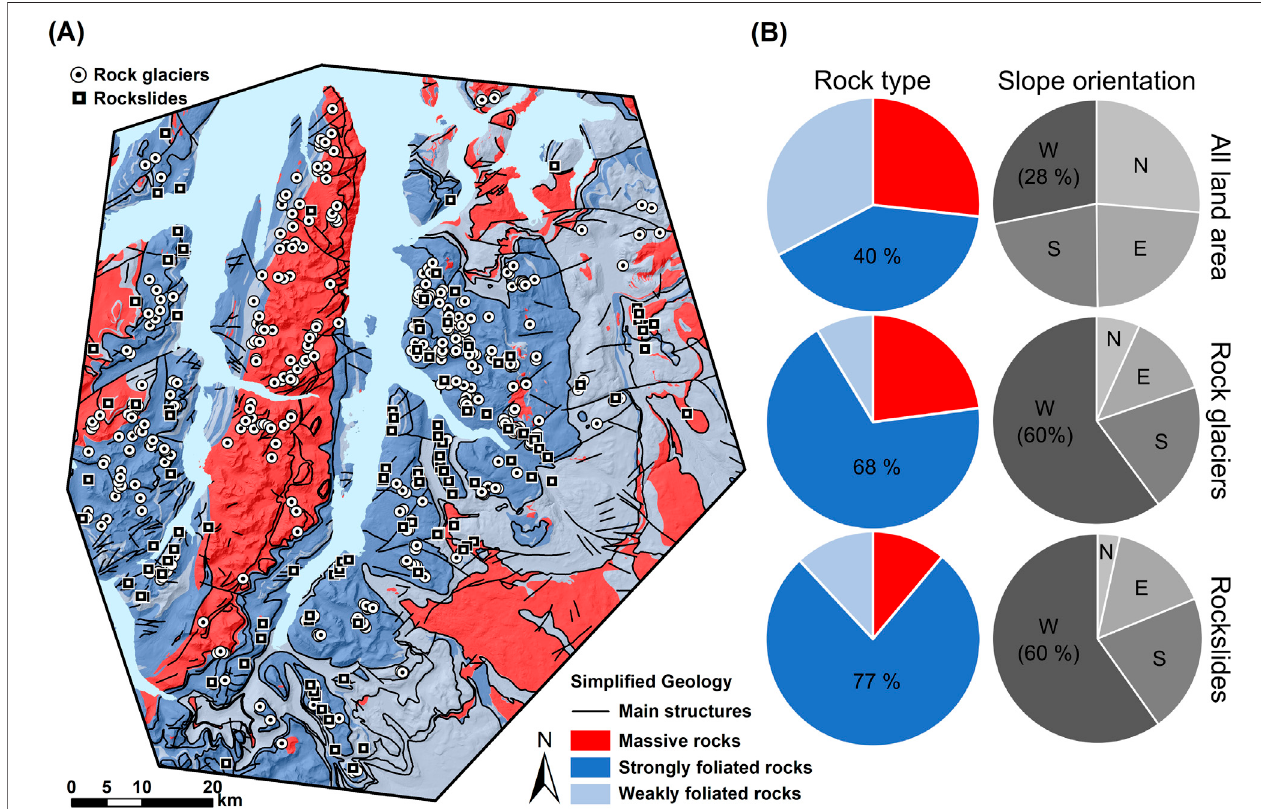
FIGURE 13 | Rock glacier (RG) and rockslide (RS) distribution and geological factors. (A) Simpli fi ed geological map, classi fi ed into 1135 three main rock types (massive, strongly foliated and weakly foliated) and structural information 1136 (major faults, joints and shear zones) from a 1:250 000 geological map of the area (NGU, 2020a; 1137 Zwaan, 1988; Zwaan et al., 1998). (B) Pie charts comparing the fraction of rock type and slope 1138 orientation for all land areas and RG/RS landforms. Slope orientation is based on a 10 m DEM 1139 (NMA, 2016).